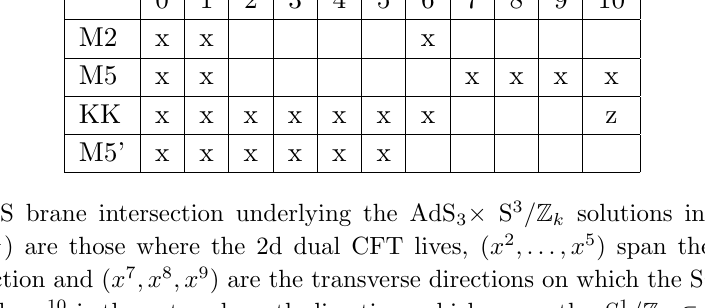
Figure 2 . Generic quiver (cid:12)eld theories dual to the AdS 3 solutions with vanishing Romans’ mass. 0